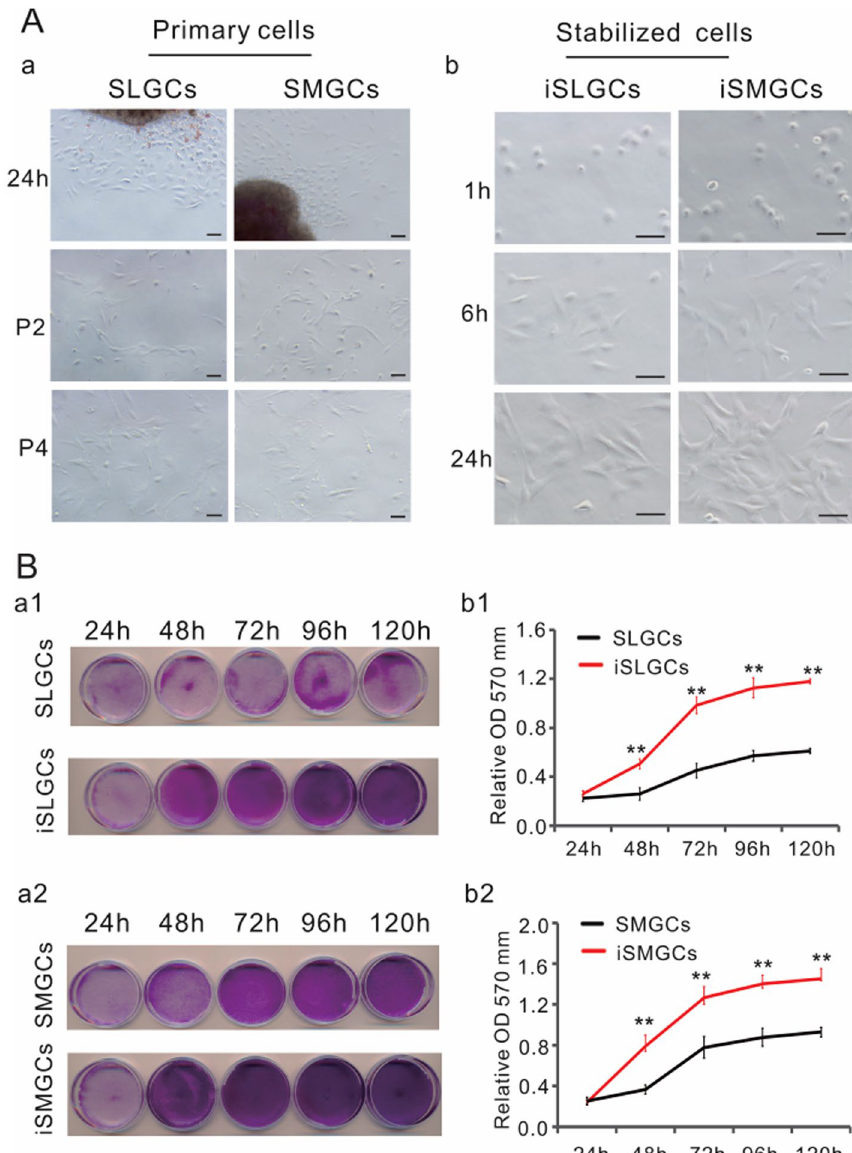
Fig. 2 Isolation and immortalization of SMGCs (iSMGCs) and SLGCs (iSLGCs). A Primary SMGCs or SLGCs were isolated on P0 SMG or SLG (captured under transmission light) and cultured in complete DMEM medium. a Morphology of primary cells at 24 h after planting, in addition to passage 3 (p2) and p4. b Establishment iSMGCs and iSLGCs. Primary SMGCs or SLGCs were infected with retrovirus SSR#41 and selected in hygromycin-containing medium for 3 days. The surviving cells were designated as iSMGCs or iSLGCs. The immortalized cells of iSMGCs or iSLGCs were photographed at the indicated time and maintained indefinitely (passage 25 is shown). B Cell proliferation was assessed via crystal violet staining assay. The same number of primary SMGCs or SLGCs (passage 2) and iSLGCs (a1) or iSMGCs (a2) were seeded at a low density and fixed with paraformaldehyde for crystal violet staining at the indicated timepoints. The stained cells of iSMGCs (b1) and iSLGCs (b2) were dissolved in 10% acetic acid and detached for OD measurement to quantitatively determine at A 570 nm to A 590 nm . The assays were performed in triplicate. ** P <